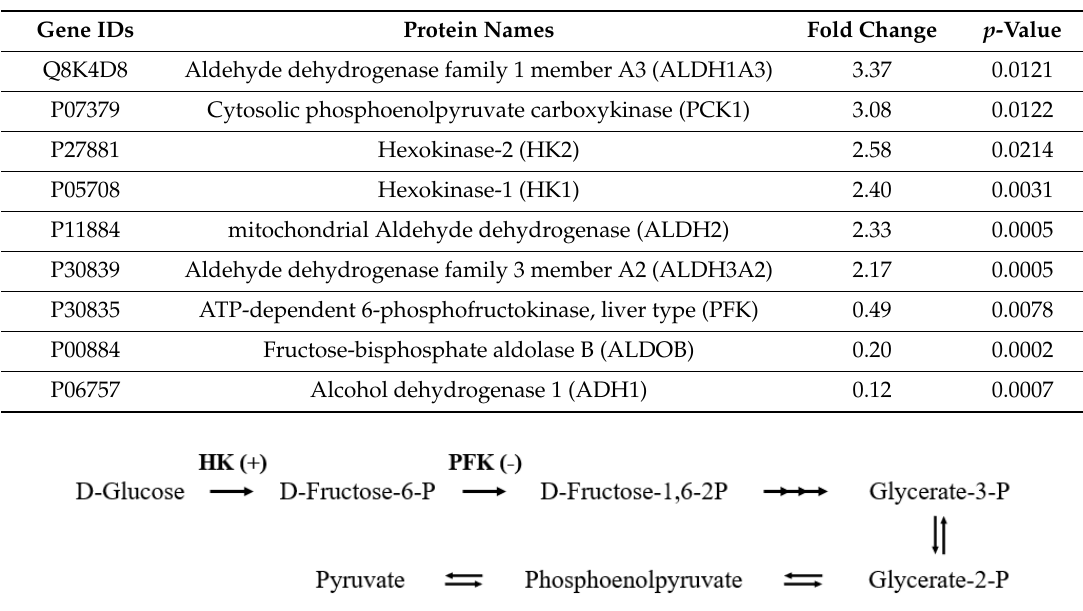
Table 1. DEPs involved in glucose metabolism.